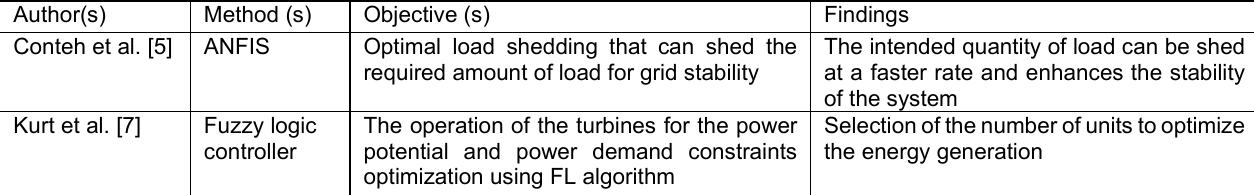
Table 1. Summary of applications of AI for performance